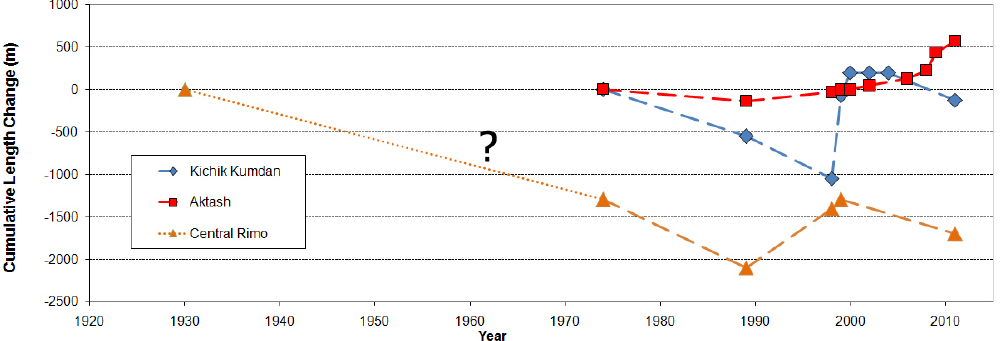
Fig. 5. Cumulative length records of Central Rimo and Kichik Kumdan and Aktash glaciers during 1973–2011. Dotted line for Central Rimo Glacier indicates that there were no observations between 1930 and 1973 in our study.